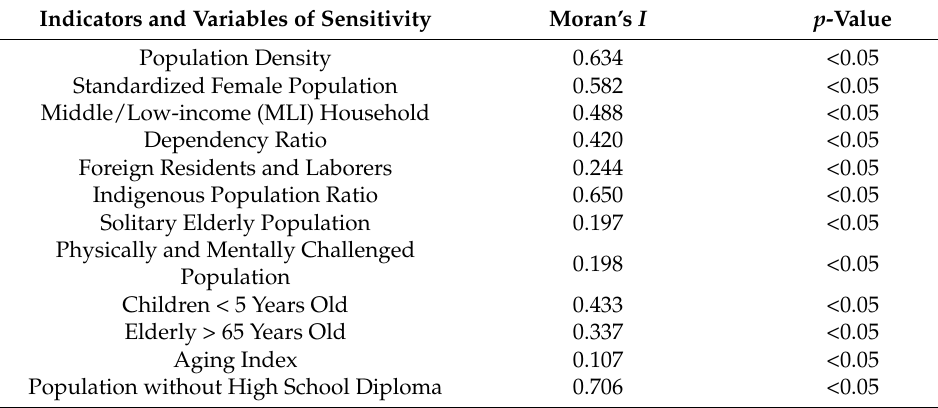
Figure 2. The spatial distribution of exposure to natural hazards. Table 1. Indicators and variables of